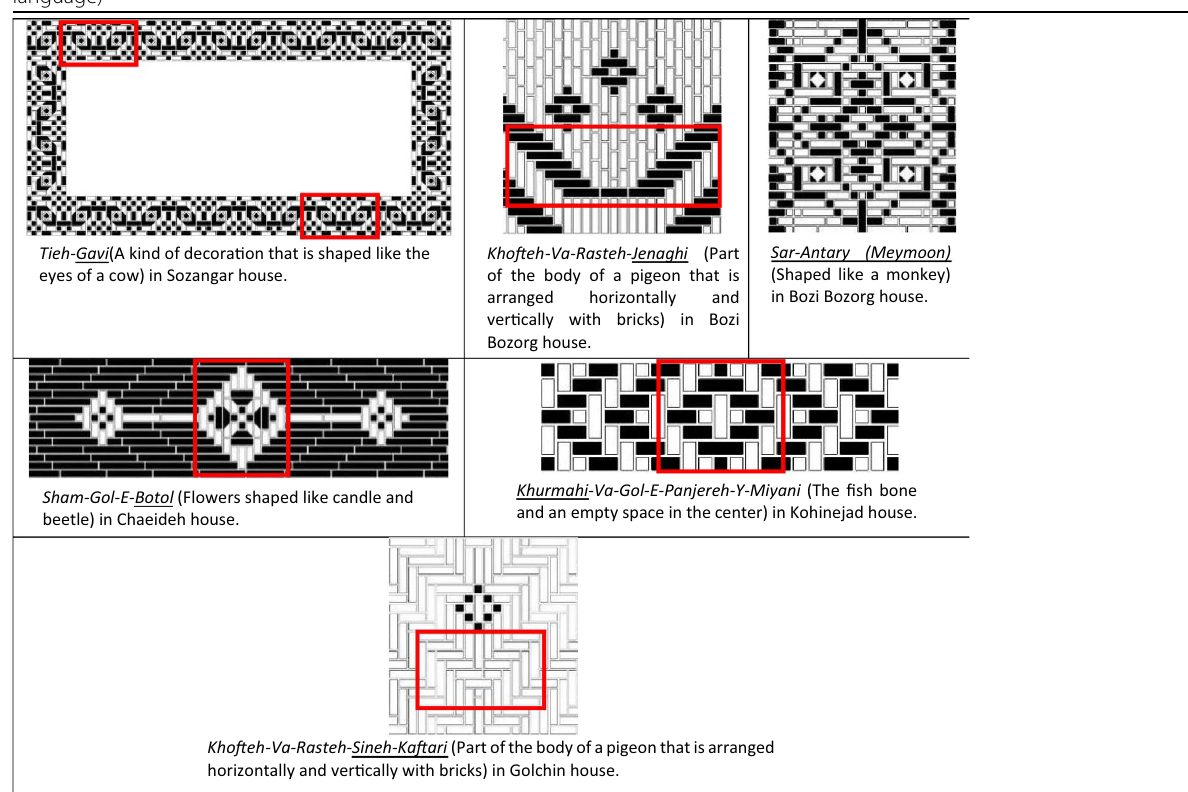
Table 4 The Xowun names in animal motifs (the name of the brick decoration is derived from architectural terms in the native